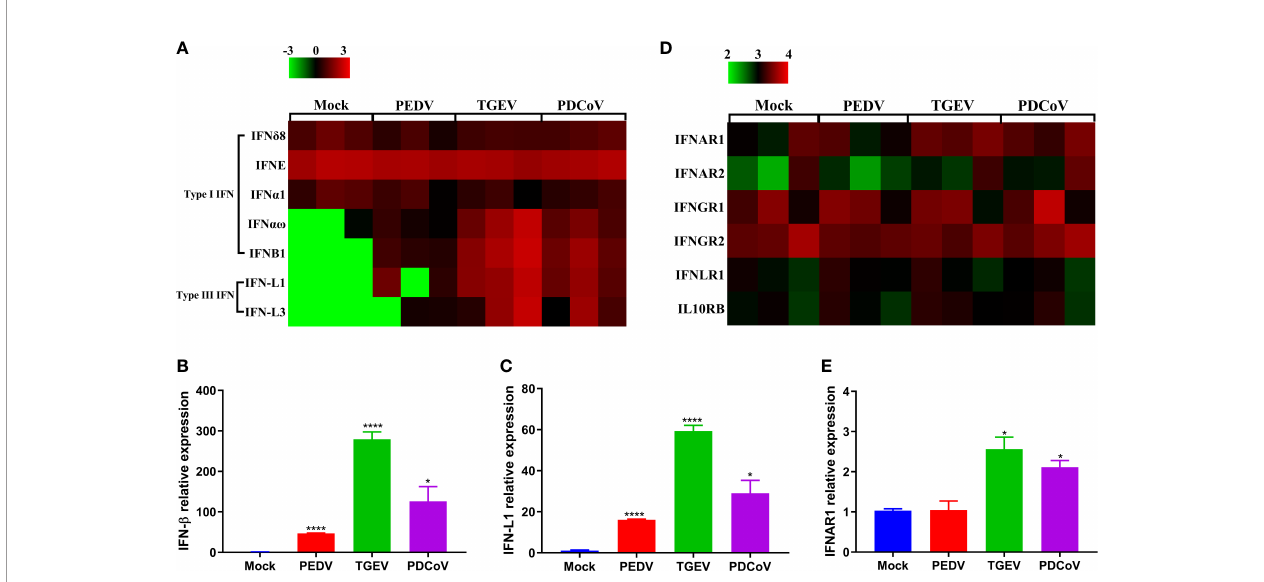
FIGURE 5 | PEDV infection displays a weaker induction of IFN responses in enteroids than TGEV and PDCoV. (A, D) Heat map of IFNs and IFN receptors expression in enteroids after SECoVs infection. Jejunal enteroid monolayers were mock-infected or infected with PEDV, TGEV, or PDCoV for 24 h. The differential expression pro fi les of IFNs (A) and IFN receptors (D) were analyzed by RNA-Seq. Data are based on log(RPKM) values (n = 3). (B, C, E) . Con fi rmation of IFNs and IFNAR1 expression in enteroids after SECoVs infection by RT-qPCR. Monolayers of jejunal enteroids were infected with PEDV, TGEV, or PDCoV for 24 h. The mRNA expressions of IFN- b (B) , IFN-L1 (C) , and IFNAR1 (E) were assessed by RT-qPCR. The results are presented as the means ± SEMs (n = 3). The differences between groups were compared using the Student ’ s t test. Error bars denote the deviations, and the p values are expressed as follows: * p < 0.05, and **** p <